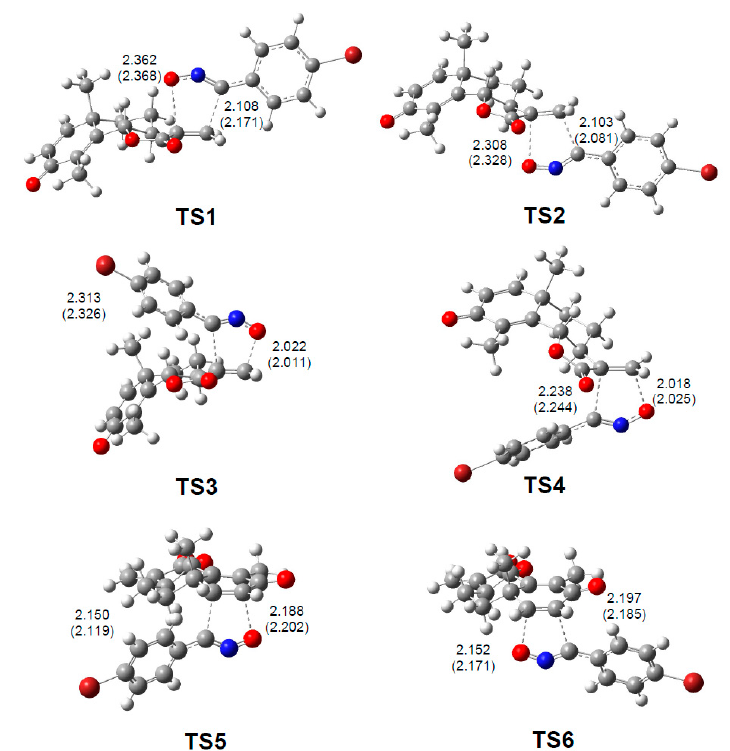
Figure 4. MPWB1K/6-311G(d,p) optimized geometries of the regioisomeric TSs involved in the 32CA reaction of α -santonin derivative 2 with p -bromophenyl nitrile oxide 3 . Values in THF are given in parentheses. Distances are given in angstroms, Å.